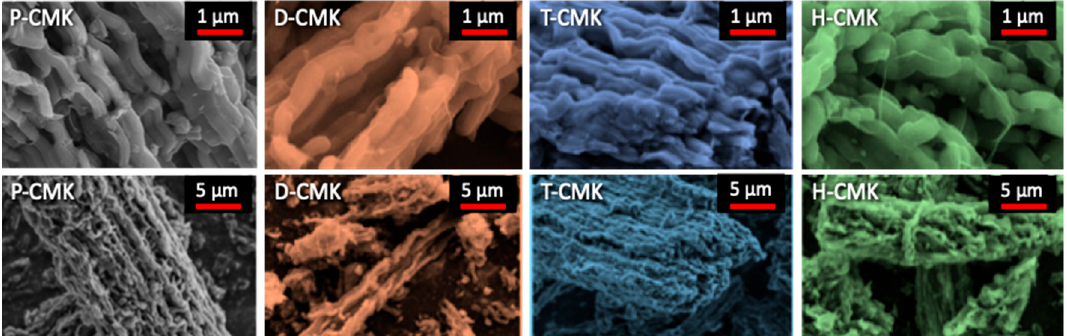
Figure 2. SEM microphotographs of initial and modified OMCs.